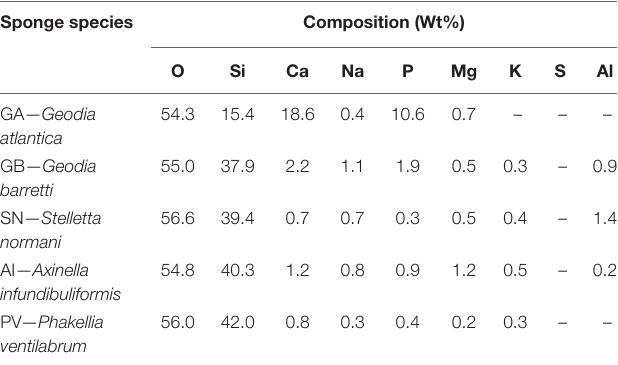
TABLE 2 | Chemical composition of the surface of the biosilicas after 28 days of immersion in simulated body fluid (SBF). Sponge